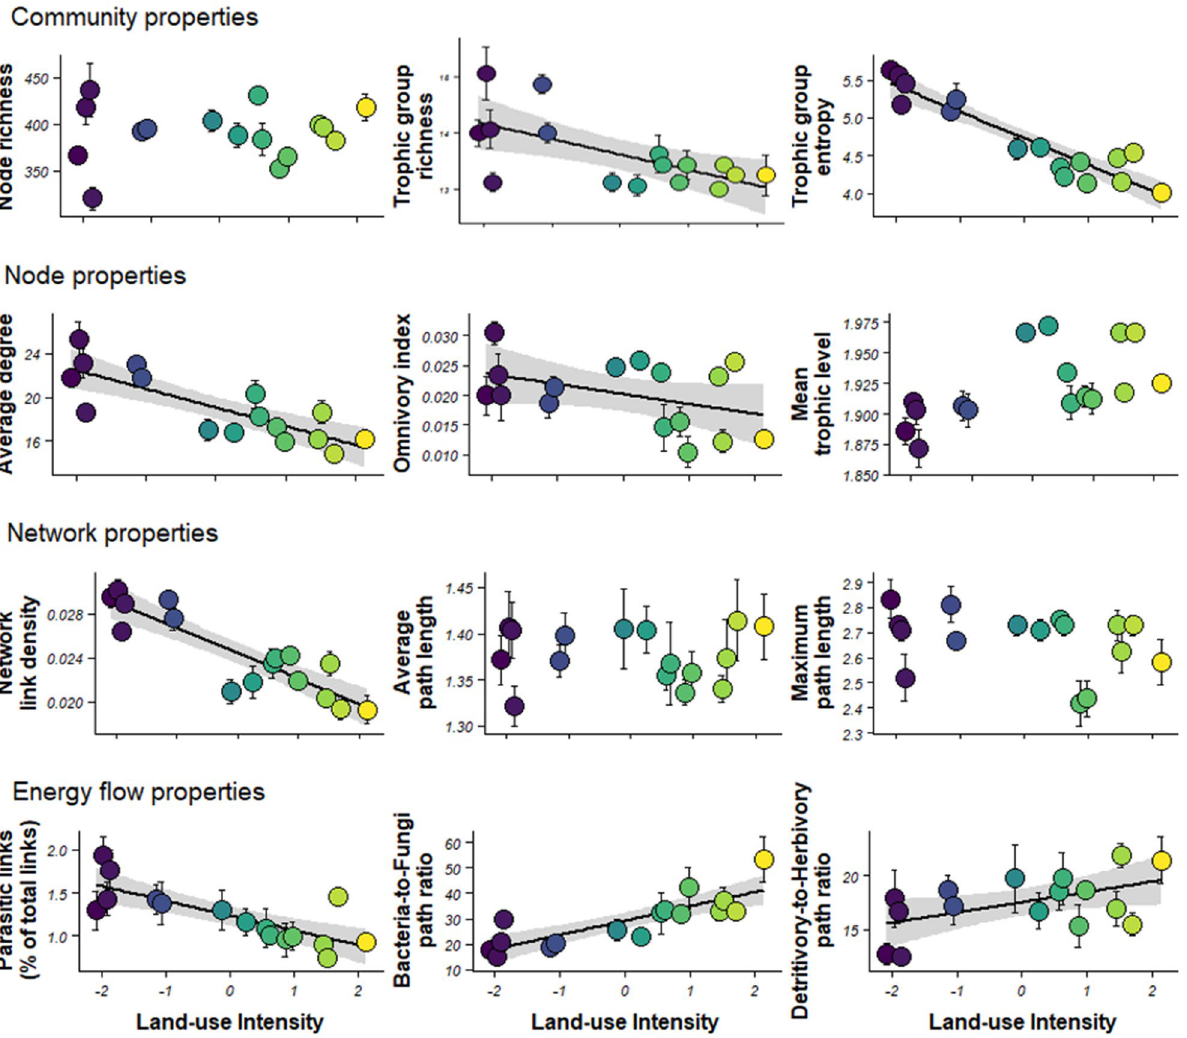
Figure 2. Relationships between land-use intensity and average trophic network properties across experimental fields. Regression lines and 95% CI are shown where significant. Network metrics are given in Table 2. The colour code emphasizes the land-use intensity gradient from least intensive (purple) to most intensive